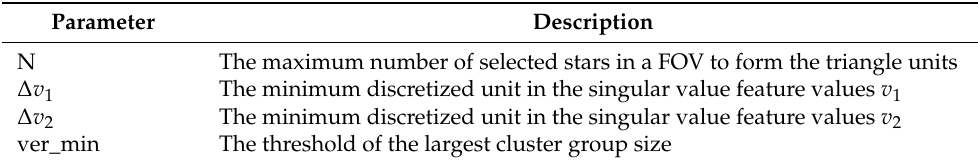
Table 1. Key parameters in the multilayer voting method and brief descriptions.